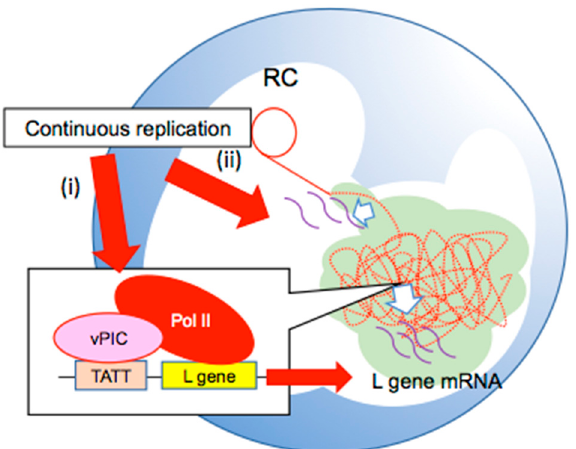
Figure 4. The interaction between continuous replication and vPIC-dependent or -independent L gene transcription in RCs. (i) Continuous replication is required by vPIC-dependent L gene transcription. vPIC, including viral TBP-like protein, interacts with the TATT motif on the L promoter region of viral DNA stored in the BMRF1-core. (ii) Some sets of L genes are transcribed independently of vPIC. Viral DNA replication stimulates such gene transcription.